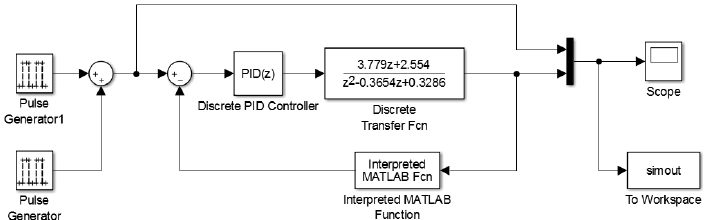
Figure 8. Plant used in the WCNS simulation with sampling period of 350 ms.